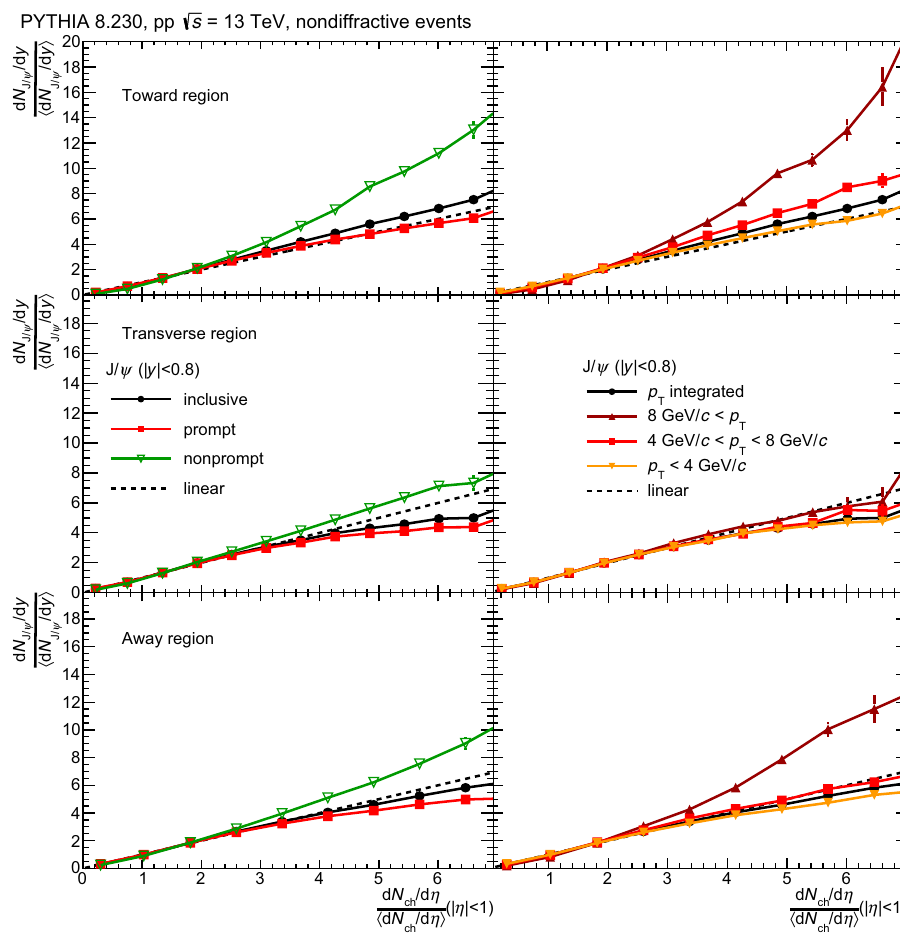
Fig. 13 Self-normalized J /ψ yield at mid-rapidity as a function of self-normalized charged-particle multiplicity at mid-rapidity in PYTHIA8.230. The panels are as in Fig. 10